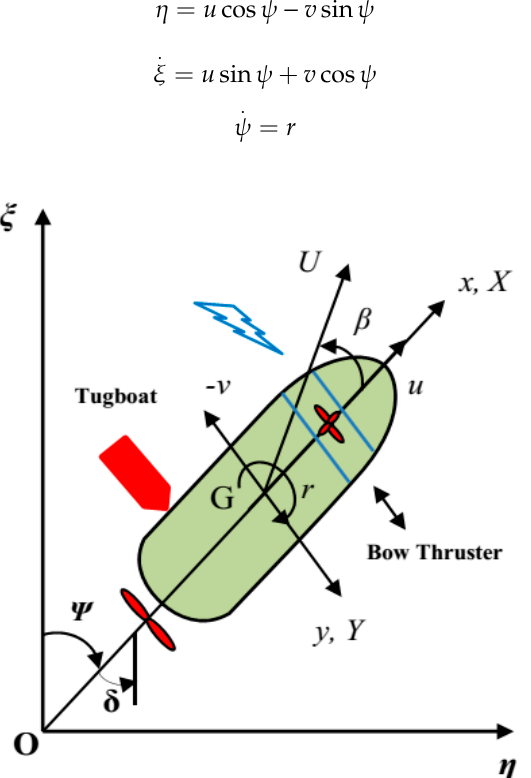
Figure 1. Ship dynamic in the Cartesian reference frame.